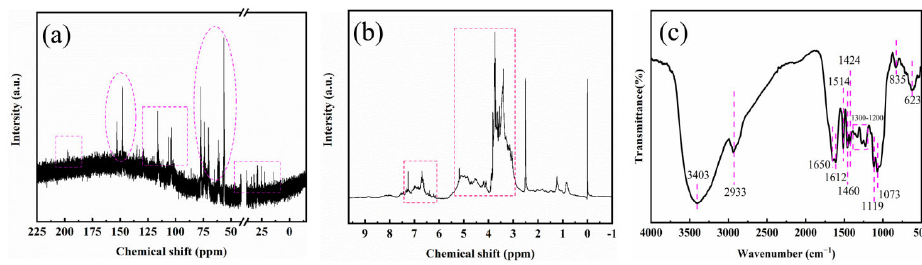
Figure 1. Chemical characterization of the colorant by: ( a ) 13 C-NMR spectra ( b ) 1 H-NMR spectra ( c ) FTIR spectra.